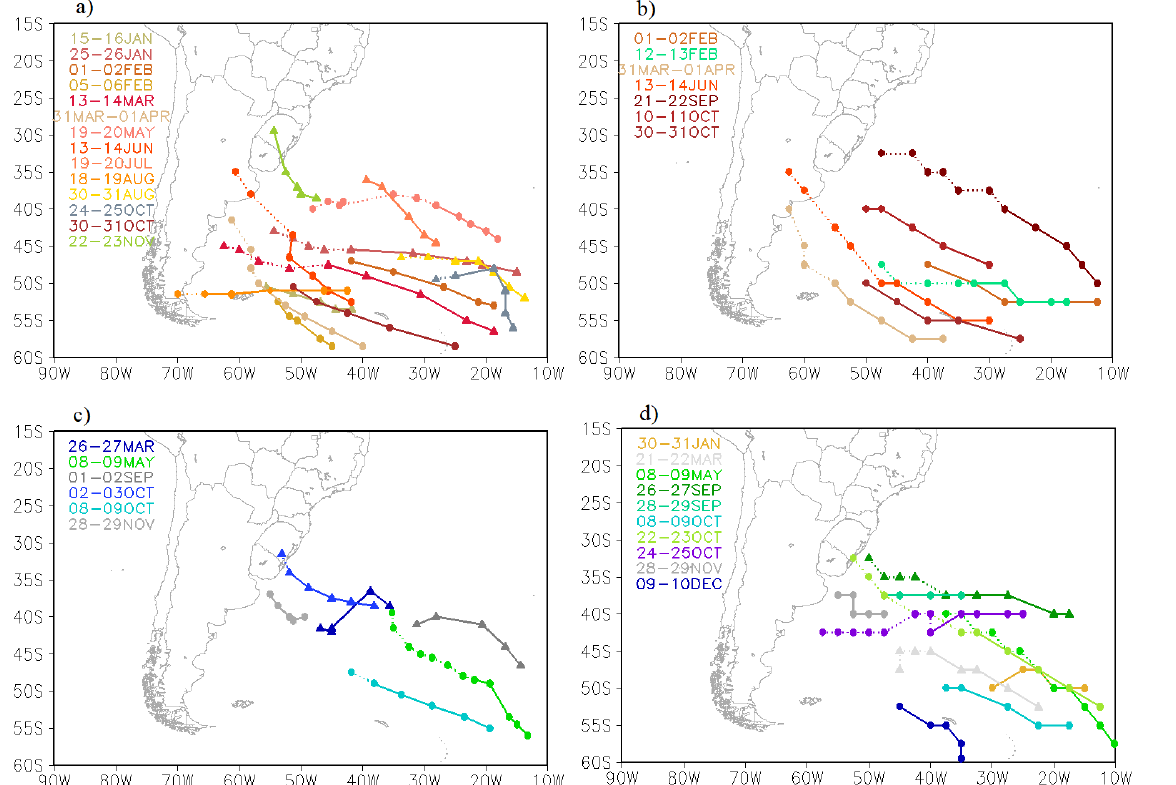
Figure 1. Trajectories of weak explosive cyclones (dashed lines – non-explosive phase; solid lines – explosive phase): a) MERRA-2 in 2014; b) NCEP2 in 2014; c) MERRA-2 in 2015; d) NCEP2 in 2015. Systems with solid circle trajectories are common cases of the two reanalyses, while those with solid triangle trajectories are cases only of the presented